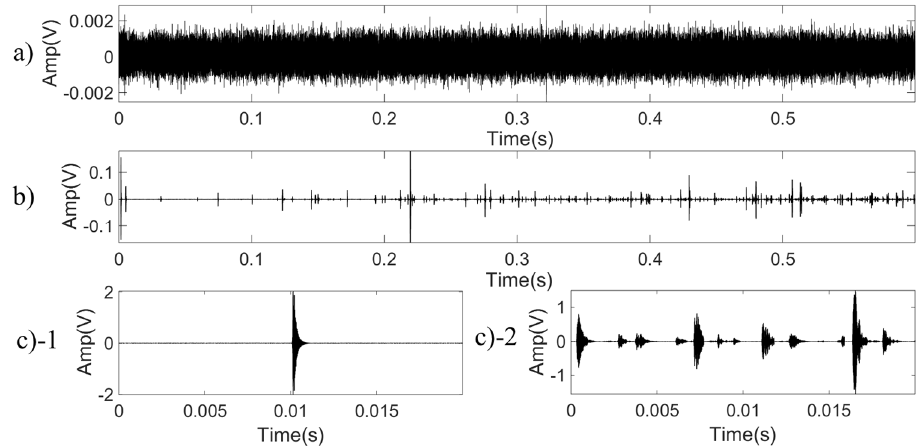
Figure 8. Typical signals in different stages of self-healing detection: ( a ) beginning, ( b ) partial discharge, and ( c ) self-healing. (1—MFCs with Δ connections; 2—MFCs with Y-N